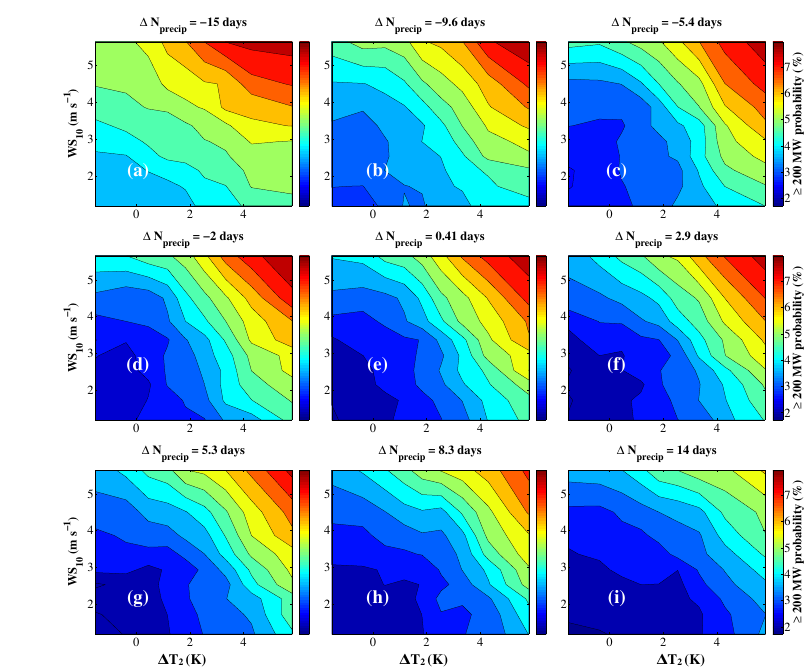
Figure 5. Estimated probabilities of fire intensity (FRP) exceeding the 200ha threshold. The x axis is the 2m air temperature anomaly ( (cid:49)T 2 ), the y axis the 10m wind speed (WS 10 ) and each panel stands for values of January–June precipitation days anomaly ( (cid:49)N precip ) centred on the given value on the panel titles.